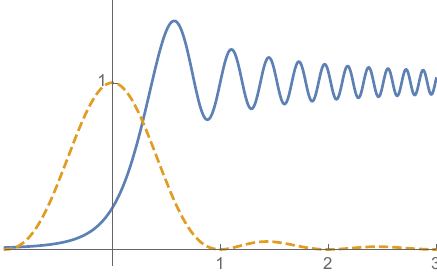
Figure 2 . The qualitative features of single-slit and edge di(cid:11)raction (intensity vs angular deviation). The only comparison intended is a note on the periodicity, which is linear for a slit but approaches quadratic for a sharp